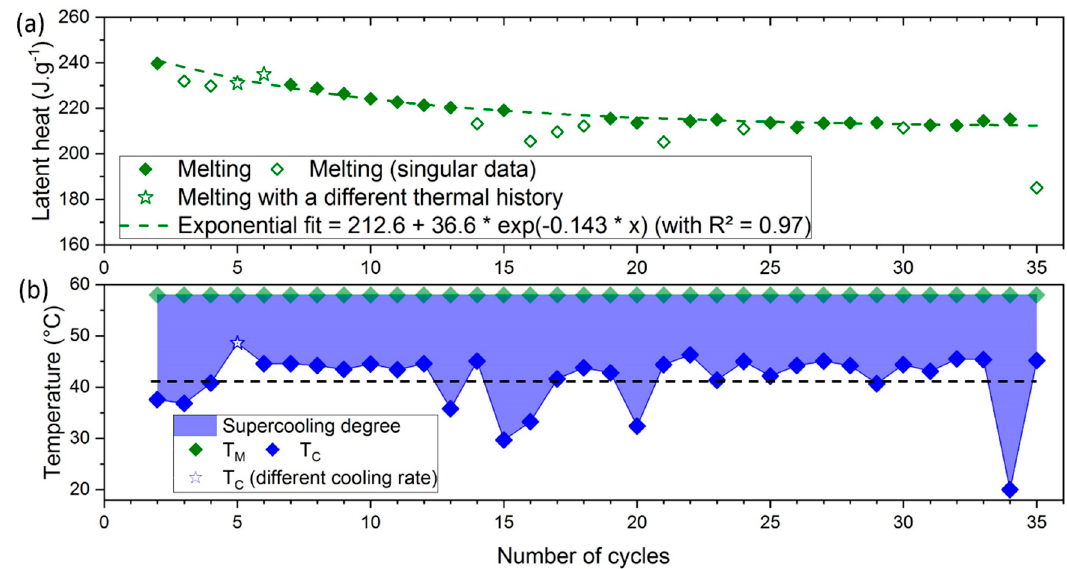
Figure 11. Evolution of ( a ) the latent heat and ( b ) the supercooling degree over 35 cycles of a raw SAT sample ( w AS = 0.603). Values for the 5th and 6th symbol (from different thermal history) are plotted as stars. The open symbols (following a low-temperature crystallization) will not be considered for exponential fit and aging analysis. T M and T C respectively represent melting and crystallization temperatures.